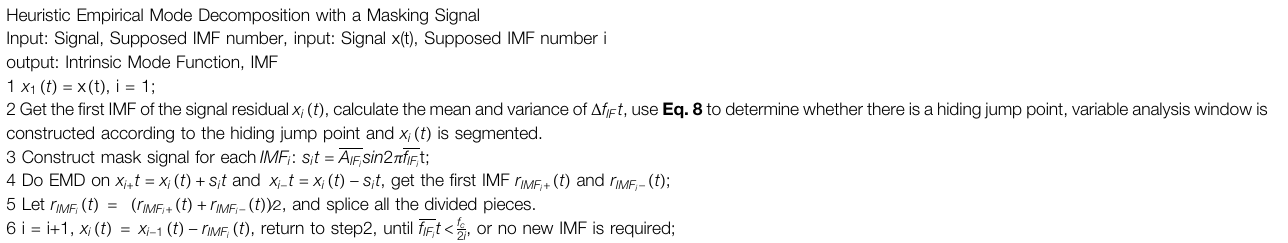
Algorithm 2 | Heuristic empirical mode decomposition with a masking